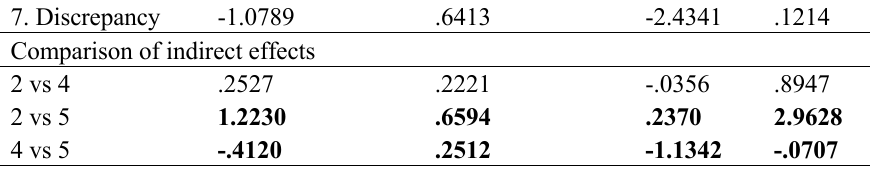
Table 4. Mediations of academic achievement on procrastination through self- efficacy and perfectionism (standards, order and discrepancy)